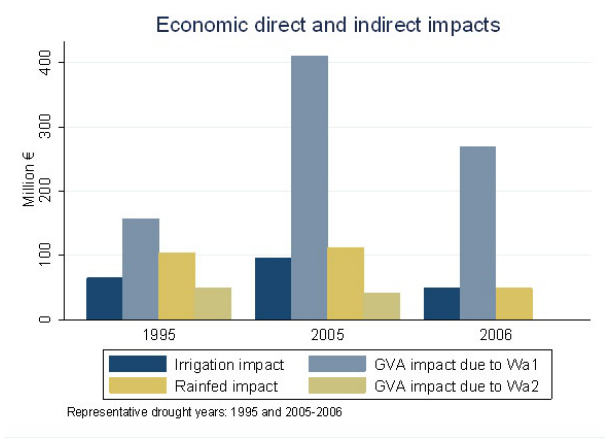
Fig. 4. Comparison of the amount of direct and indirect impacts of the 2004–2008 drought on the Ebro River basin (million